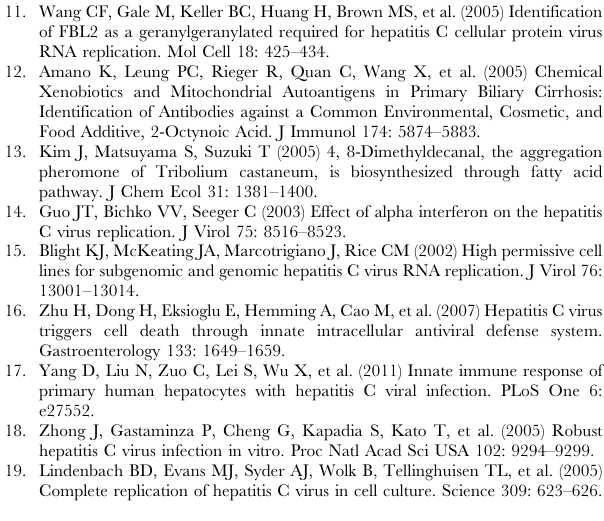
Figure S2 The effect of 2-OA on HCV RNA replication at short time points. HCV-infected Huh7.5 cells were treated by 2-OA for 10 minutes, 2 hours and 4 hours. Total cellular RNA was isolated from the cells. HCV RNA was detected by real-time PCR analysis and normalized with GAPDH. (TIF) Figure S3 2-OA inhibits miR-122 expression in HCV- infected hepatocytes through activated AMPK. HCV- infected Huh7.5 cells were treated with 10 m M 2-OA in the presence of compound C for 48 hours. MiR-122 was detected with real-time PCR and normalized with GAPDH. (TIF) Figure S4 The effect of 2-OA on viability of FCA1, FL- Neo and Huh7.5 HCVcc cells measured by MTS assay. (A) FCA1 cells were treated by 10 m M and 100 m M 2-OA for 48, 72 hours. The effect of 2-OA on viability of FCA1 cells was measured by MTS assay. The data were normalized with the control and represented means of 3 independent experiments. (B) FL-neo cells were treated with 10 m M and 100 m M 2-OA for 48, 72 hours. The effect of 2-OA on viability of Fl-neo cells was determined by MTS assay. The data were normalized with the control and represented means of 3 independent experiments. (C) HCV-infected Huh7.5 cells were treated with 10 m M, 50 m M, 100 m M, and 500 m M 2-OA for 48, 72 hours. The effect of 2-OA on viability of viral-infected cells was measured by MTS assay. The data were normalized with the control and represented means of 3 independent experiments.